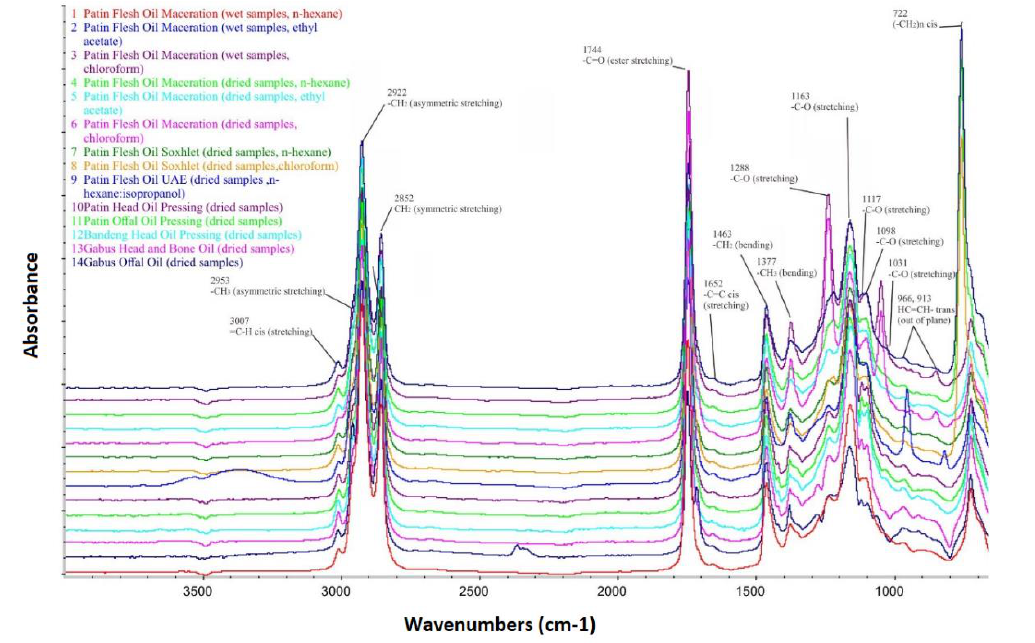
Figure 3. Attenuated total reflectance-FTIR spectra of fish oil samples from different species and extraction methods, scanned at mid infrared region (4000-650 cm -1 ).